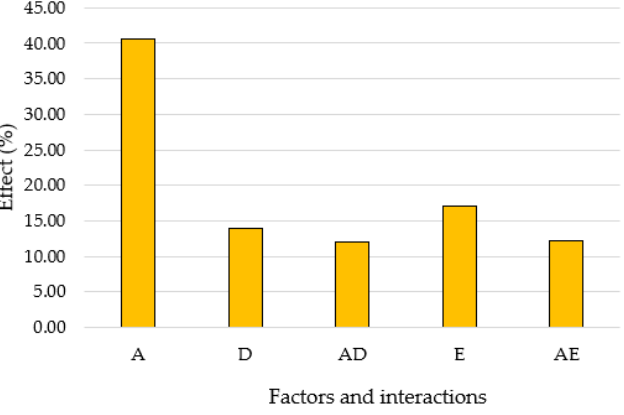
Figure 7. Main factors and their interaction effects on Pt leaching (new method).